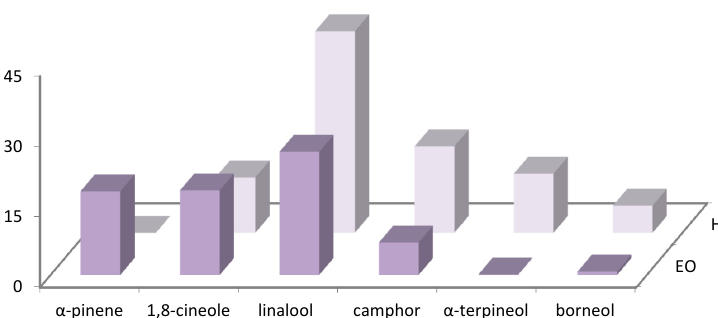
Figure 1. Bar graph of main compounds detected in vapor-phase R. officinalis Hy and EO.